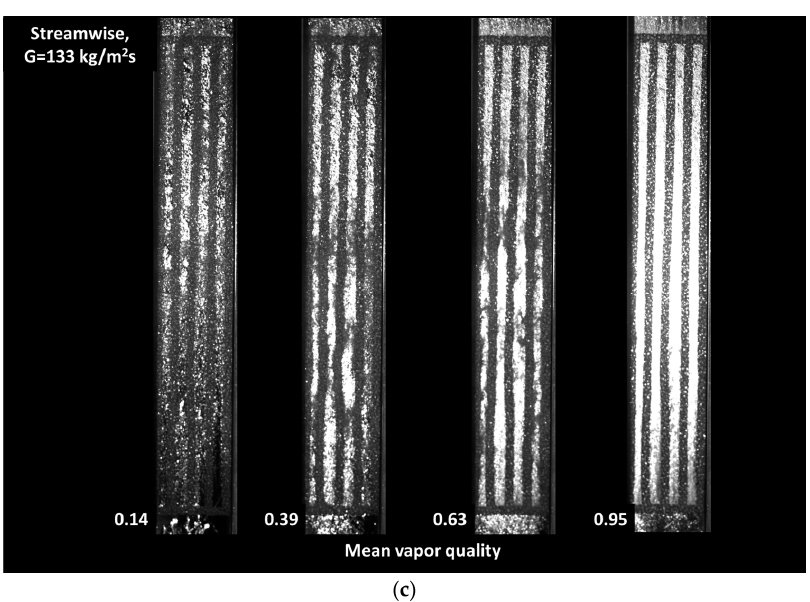
Figure 6. Visualizations of the boiling flow patterns of R245fa in ( a ) the spanwise-5 pattern model, ( b ) the spanwise-20 pattern model, and ( c ) the streamwise pattern model with 18 PPI copper porous media.